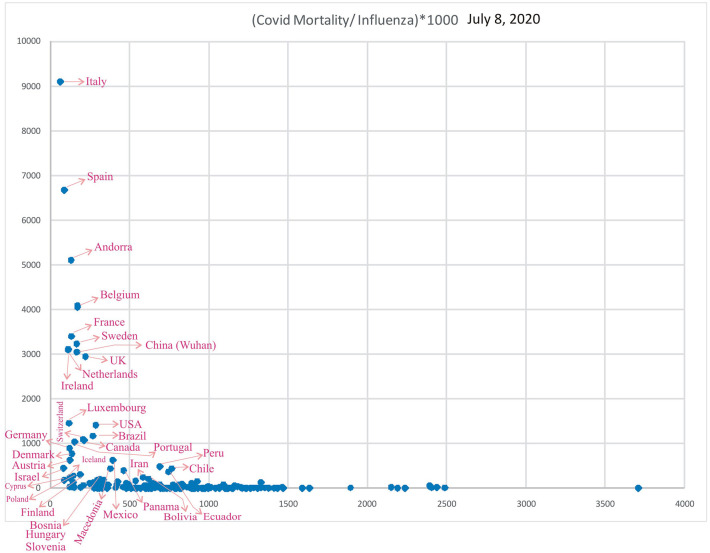
Correlation of Influenza LRI's/100,000 (x) vs. Variable (y), COVID-19 Mortality/Influenza LRI, July 8, 2020 (n = 182).